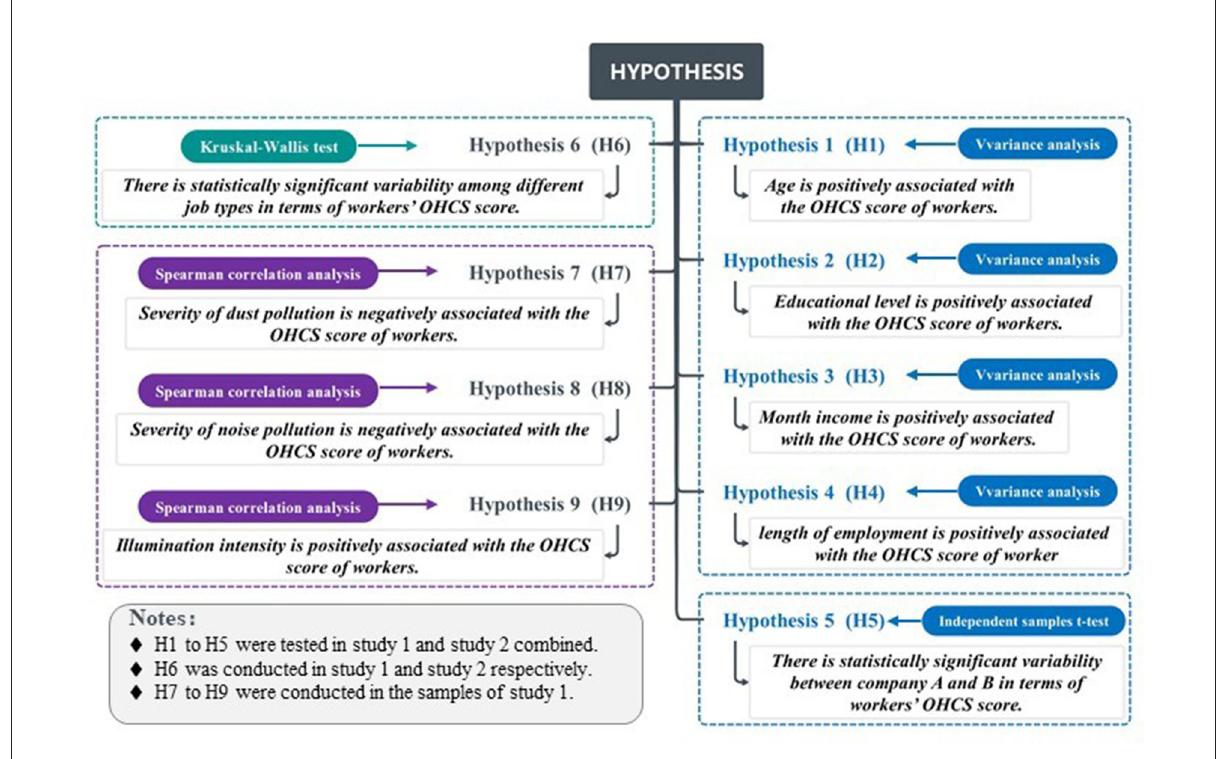
FIGURE2 Hypothesis for correlation between OHCS scores and personal factor.